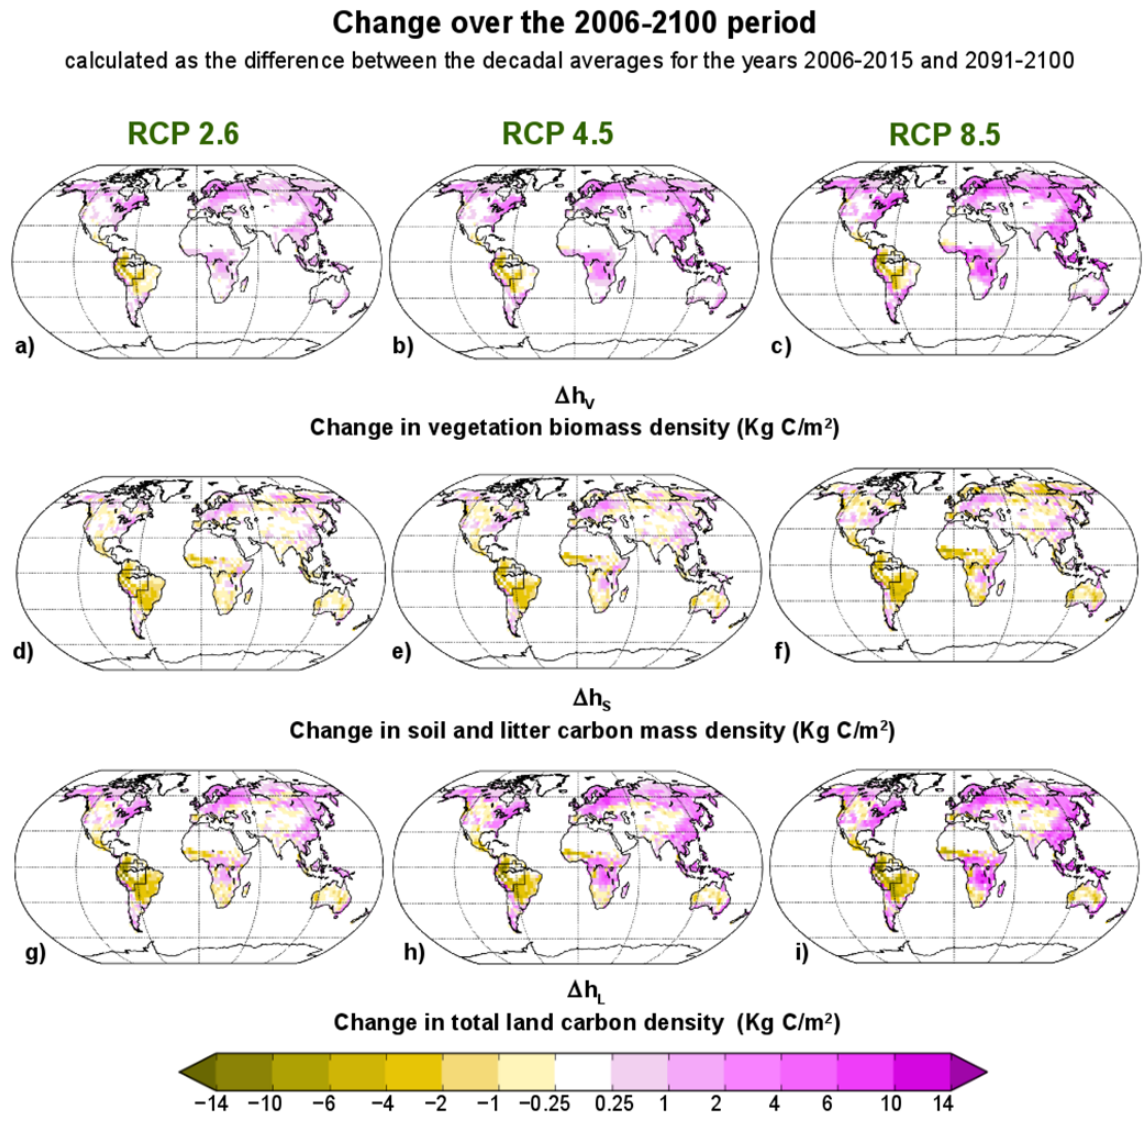
Figure 5. Geographic distribution of changes in vegetation biomass ( 1h V ) , soil plus litter carbon ( 1h S ) and total land carbon ( 1h L = 1h V + 1h S ) over the 2006–2100 period in the three RCP